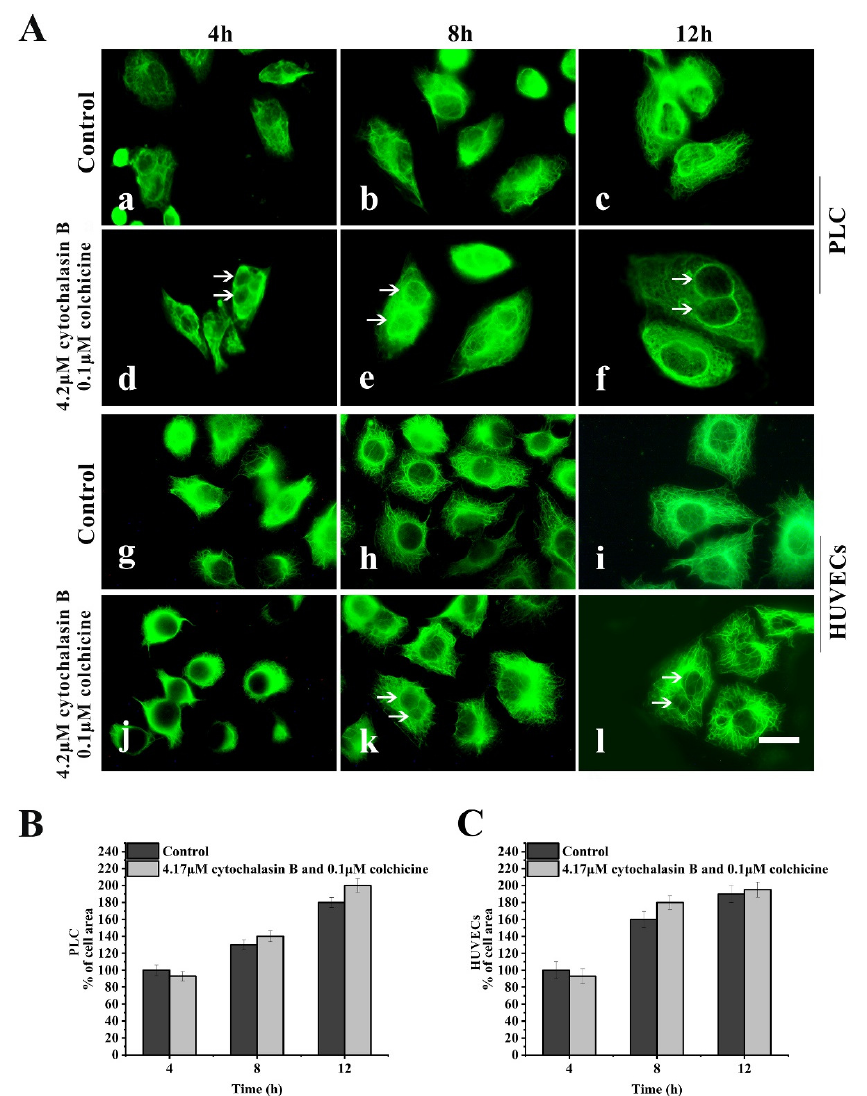
Figure 3. Effects of cytochalasin B and colchicine on KFs reassembly and cell spreading. ( A ) Representative images of KF network reassembly and cell morphology at 4–12 h after suspended PLC and HUVECs were seeded in media with cytochalasin B and colchicine (d,e,f,j,k,l) or DMSO (control, a,b,c,g,h,i), showing that treatment with cytochalasin B and colchicine does not inhibit KFs reassembly and cell spreading. 1000 × , Bar, 10 µ m. ( B , C ) Areas of cell spreading were measured at 4 h, 8 h, and 12 h after suspended HUVECs or PLC were seeded in medium-containing cytochalasin B and colchicine or in control medium (DMSO). The binucleate cells caused by cytochalasin B are indicated by arrows. Images represent typical cells from at least three independent experiments. The data shown represent the means ± standard deviation (S.D.) of three independent experiments.